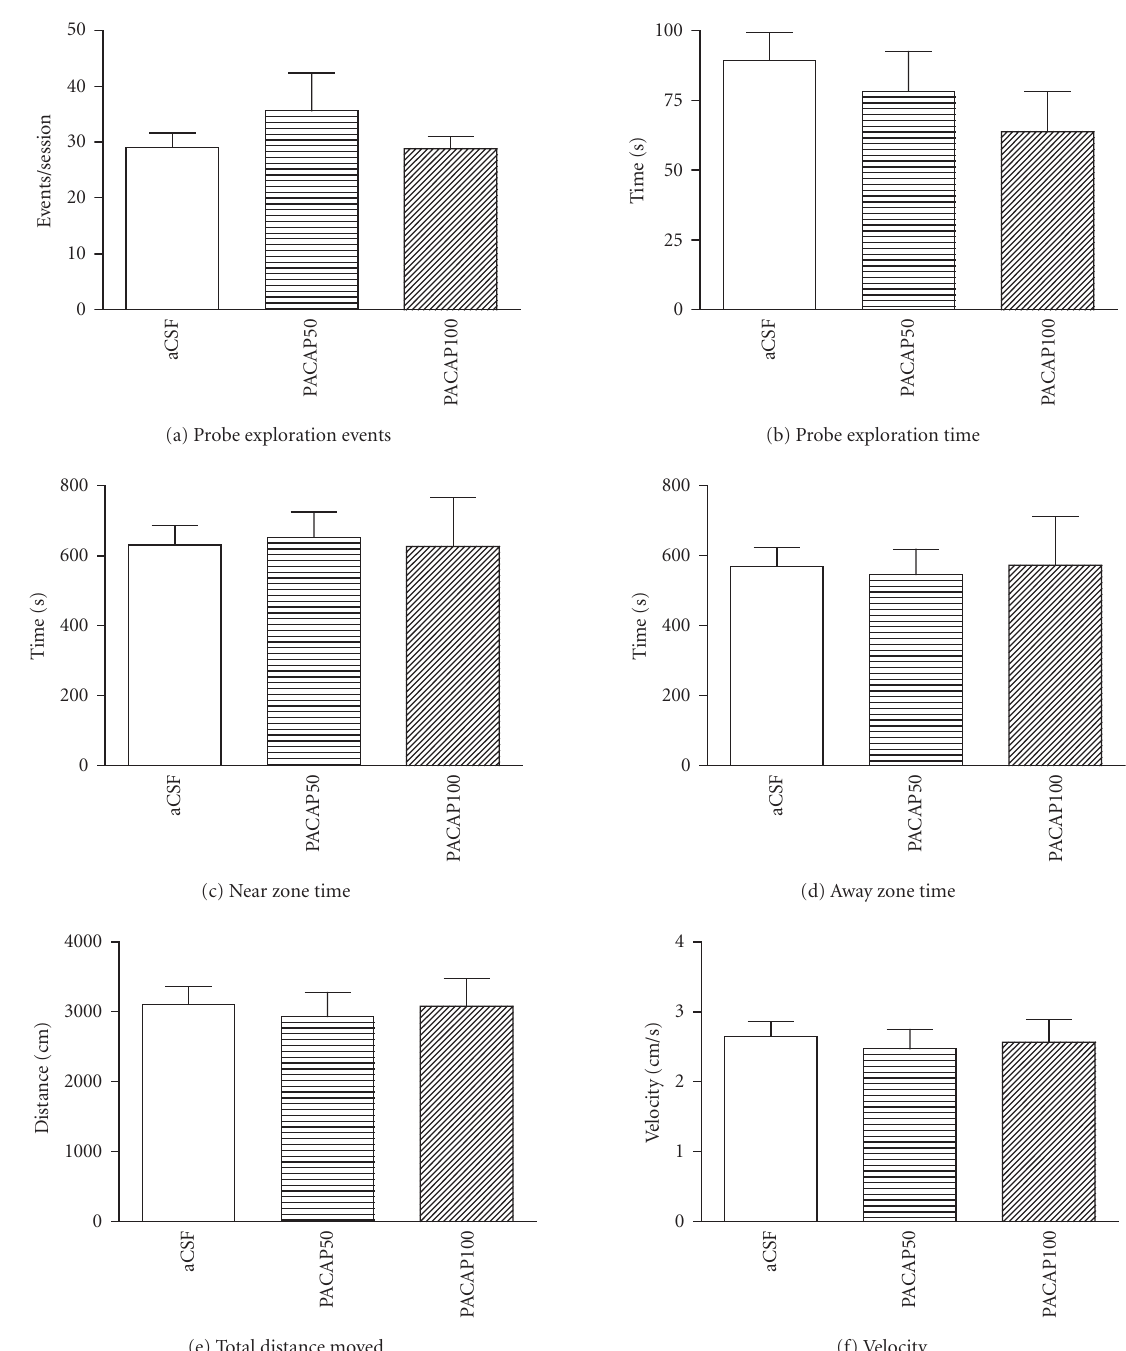
Figure 5: Summary of relevant behaviors of rats tested with the unelectrified shock probe (unshocked groups). Intra-CeA PACAP microin- jection, in the absence of shocks, had no significant main e ff ect on rat behaviors in the test chamber. (a) probe exploration events, (b) probe exploration time, (c) near zone time, (d) away zone time, (e) total distance moved, and (f) movement velocity. ∗ P < . 05 and ∗∗ P ≤ . 001 compared to aCSF controls. (aCSF n = 6/group, PACAP50 n = 4/group, PACAP100 n = 5/group.)